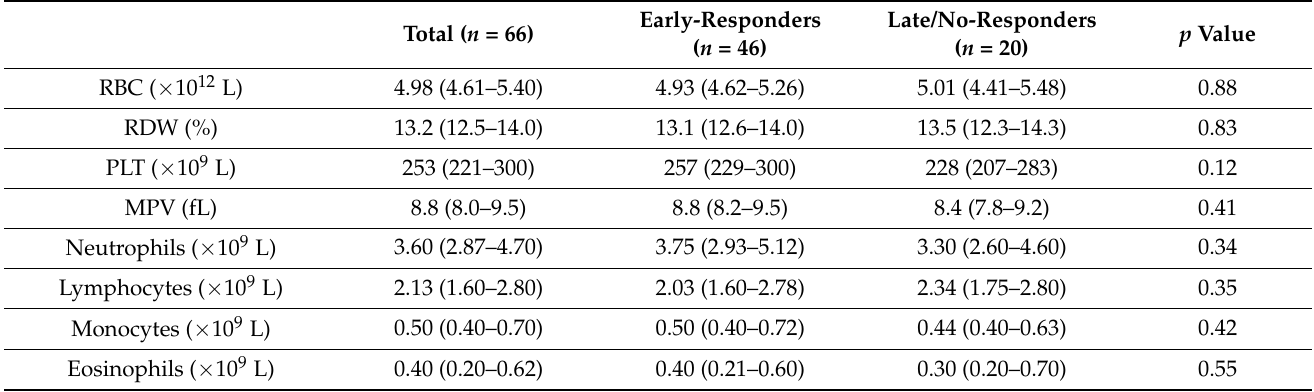
Table 2. Baseline simple haematological parameters in early-responders and